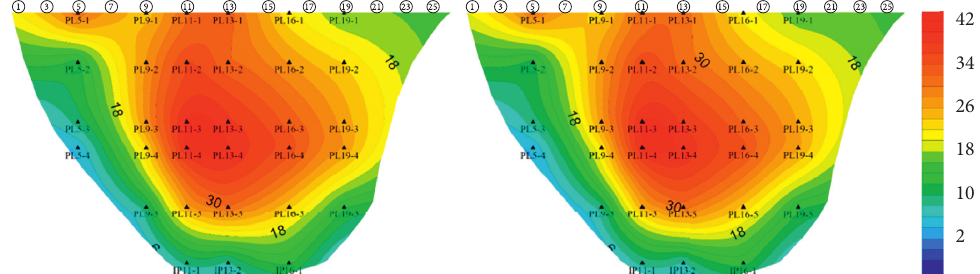
Figure 8: The nephogram comparison between the calculated (QGA) displacement values and the measured values under 1878.22